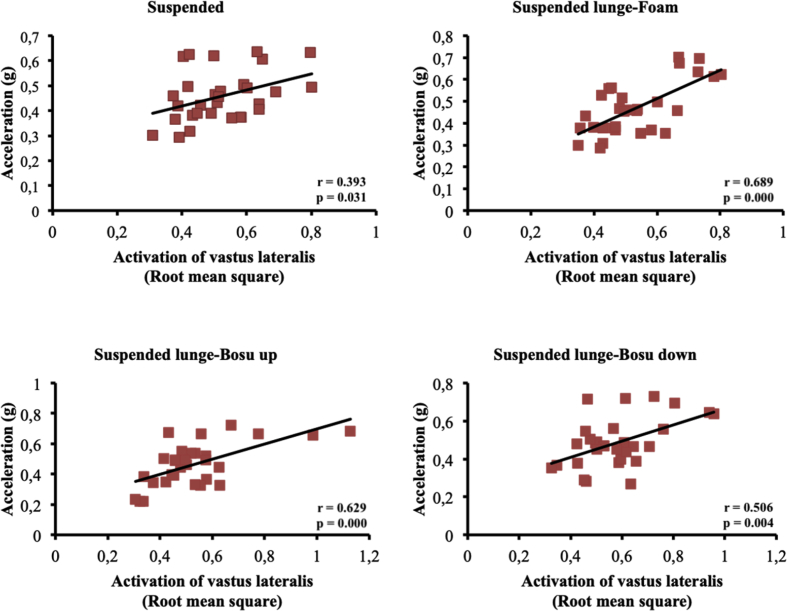
Correlation between vastus lateralis activation and acceleration values under suspended lunge conditions.